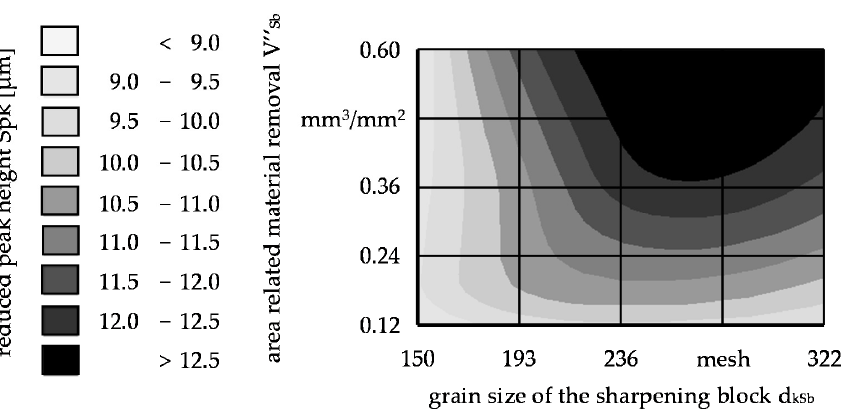
Figure 14. Influence of the interaction between d kSb and V’’ Sb on the reduced peak height Spk.